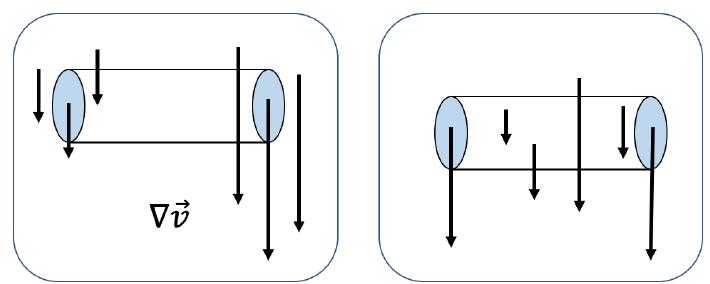
Figure 3. In the left panel, a typical example showing a gradient velocity between the ends of a stretch (geometrically represented like a cilinder); the right panel shows a situation where velocities are not uniformely